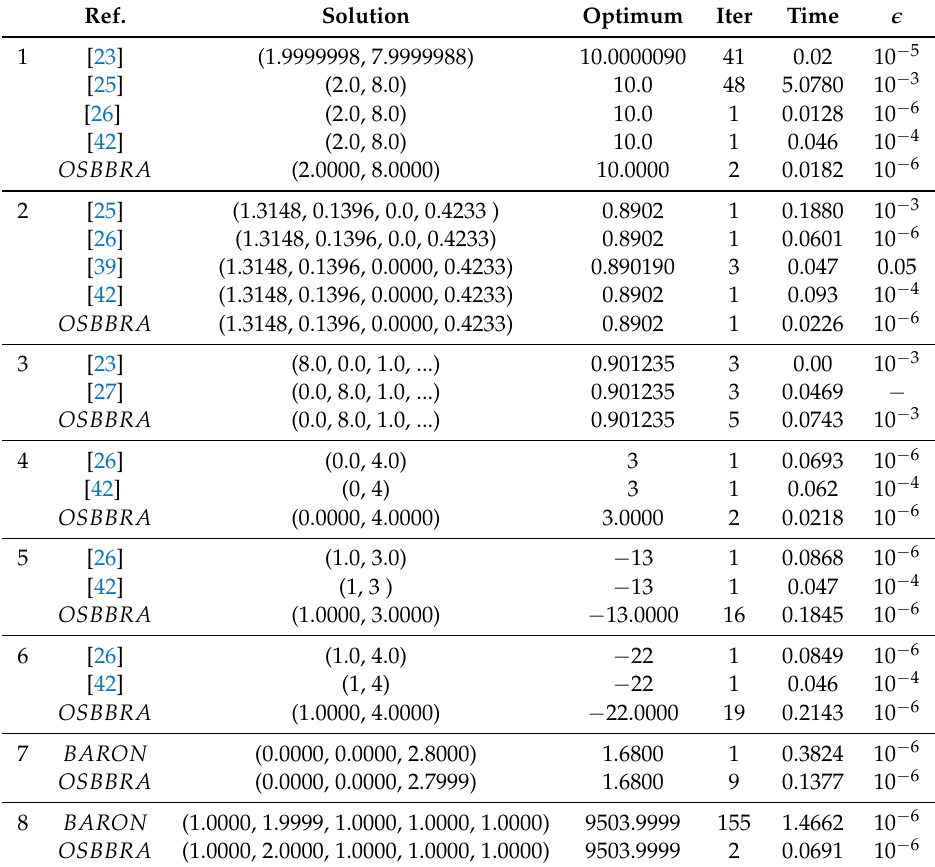
Table 1. Comparison of results in Examples